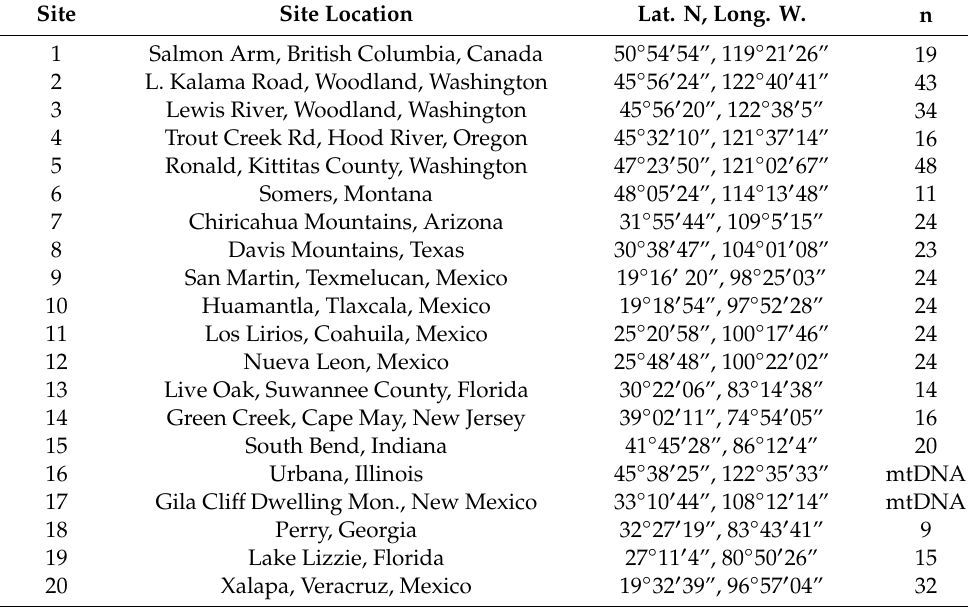
Table 1. Site number designations, locations, latitude and longitude, and number of flies genotyped from sites for microsatellites (n). Sites 1–6 were collected from Prunus emarginata (bitter cherry), sites 7–17 from P. serotina (black cherry), site 18 from Chionanthus virginicus (fringe-tree), site 19 from Osmanthus americanus (tea-olive), and site 20 from Turpinia insignis (muttonwood). Site Site Location Lat. N, Long.